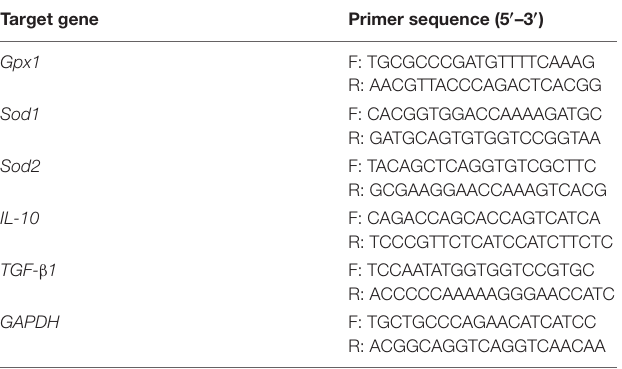
TABLE 2 | Primers for reverse transcriptase–quantitative polymerase chain reaction. Target